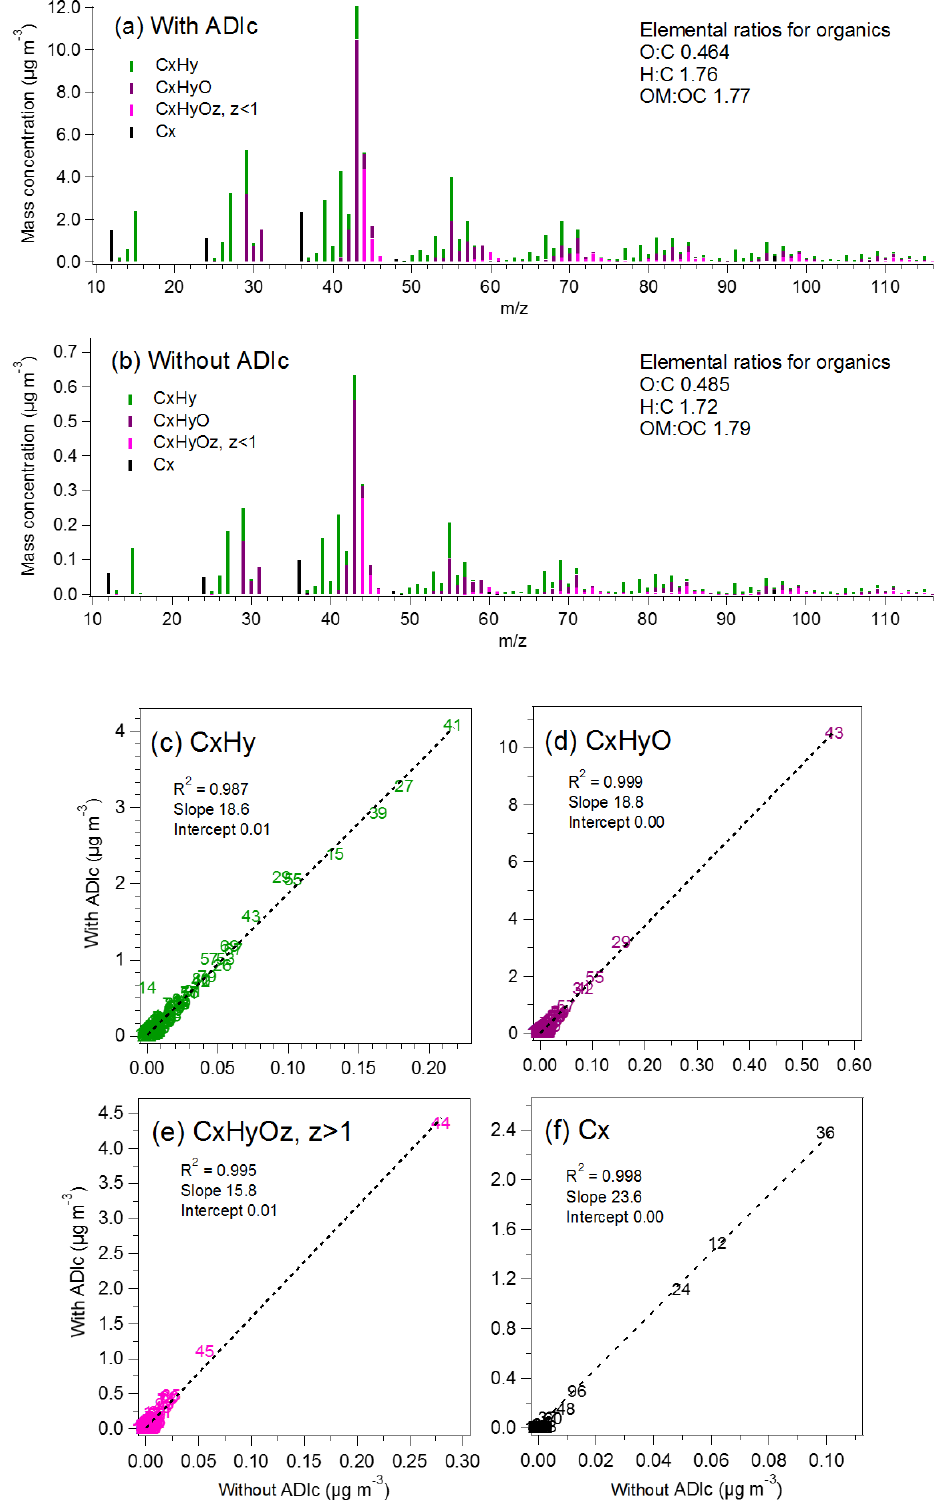
Figure 4. Mass spectra for ambient organics and rBC measured with and without ADIc ( a – b ) and the correlation of AMS fragment families ( c – f ) at SMEAR III, Helsinki. The theoretical concentration factor was